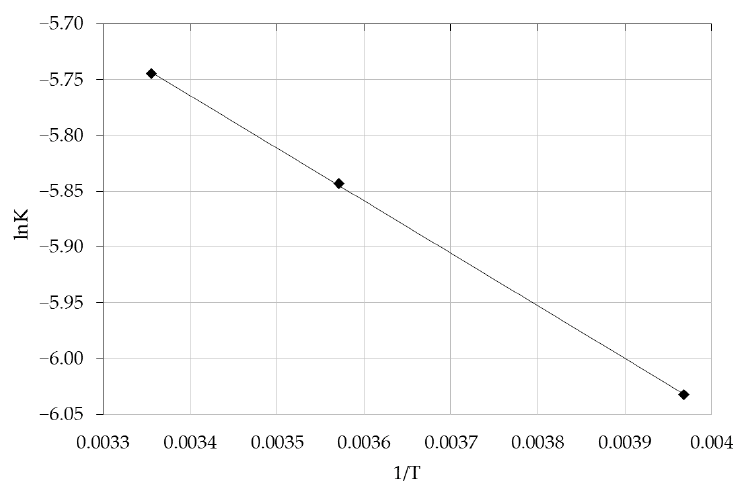
—half-conversion concentration at